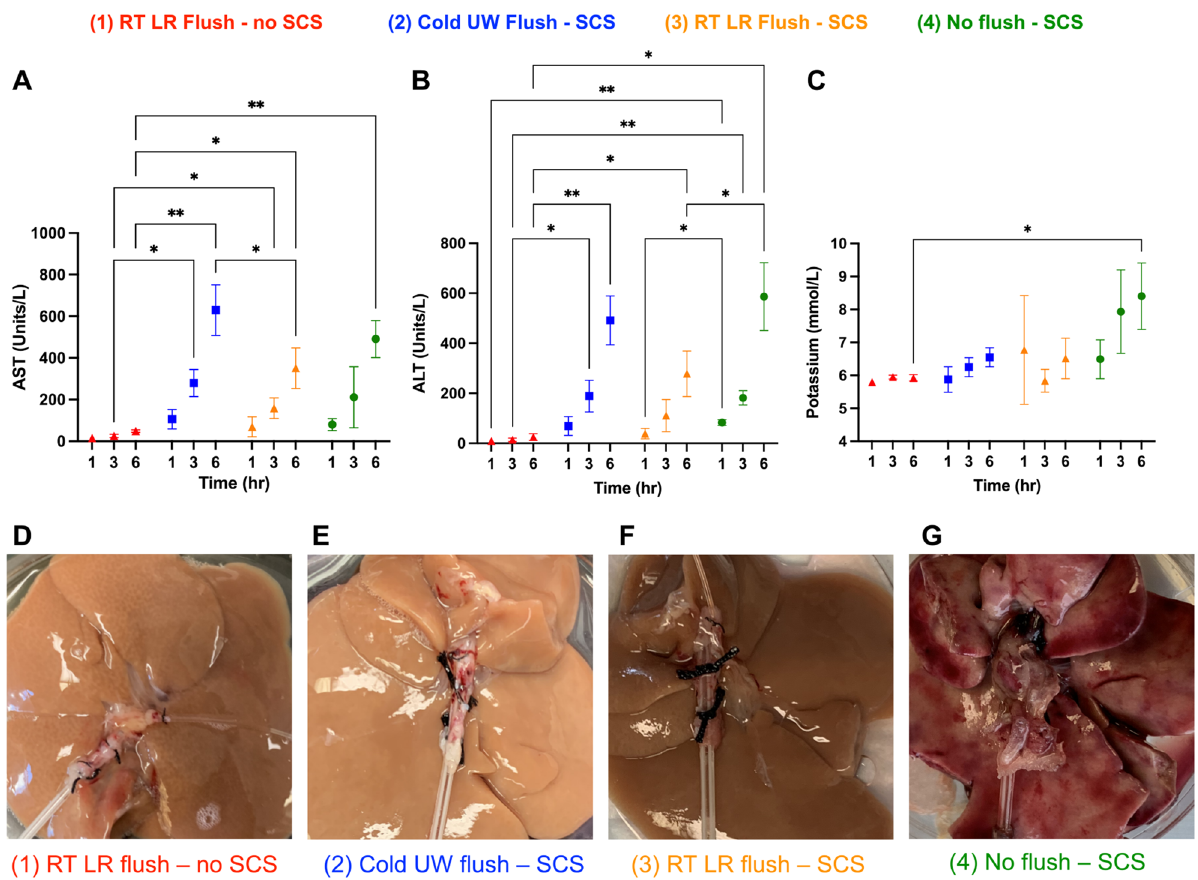
Figure 3. Perfusion injury markers of 6 h ex-vivo rat liver NMP detailing ( A ) AST, ( B ) ALT, ( C ) perfusate potassium, and ( D – G ) gross liver appearance after perfusion. RT LR flush livers with no SCS (red, n = 4) and RT LR flush livers with SCS (orange, n = 4) met transplantable criteria for AST and ALT levels while cold UW flush livers with SCS (blue, n = 4) and no flush livers with SCS (green, n = 4) did not. Grossly, group 1 and 3 livers appeared normal after perfusion while group 2 livers appeared pale from cellular washout and group 4 livers had major areas of infarction and necrosis. Stars denote statistical significance (ANOVA, followed by Tukey’s post- hoc test): *0.01 < p < 0.05; **0.001 < p < 0.01. Icons represent means and error bars represent standard